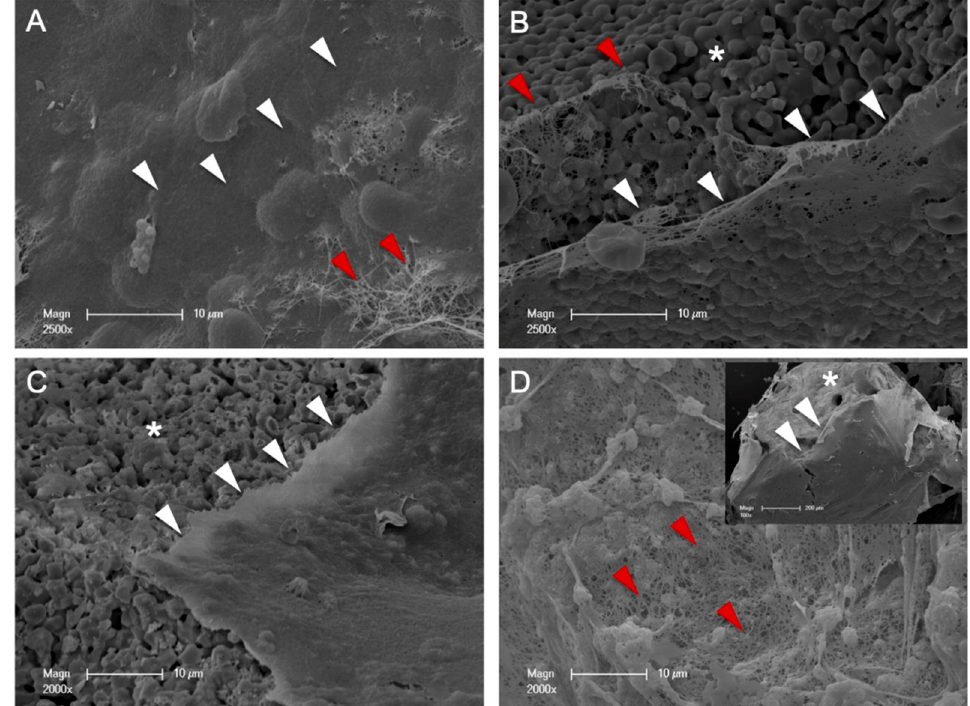
Figure 5. SEM: allogeneic ( A ), alloplastic ( B ), xenogenic material 1 ( C ), and xenogeneic material 2 ( D ) with PRF-biofunctionalization. The surfaces of the bone substitutes (*) were covered by a thin PRF-layer (white arrows) that was created by closely networked fibrin fibers (red arrows).